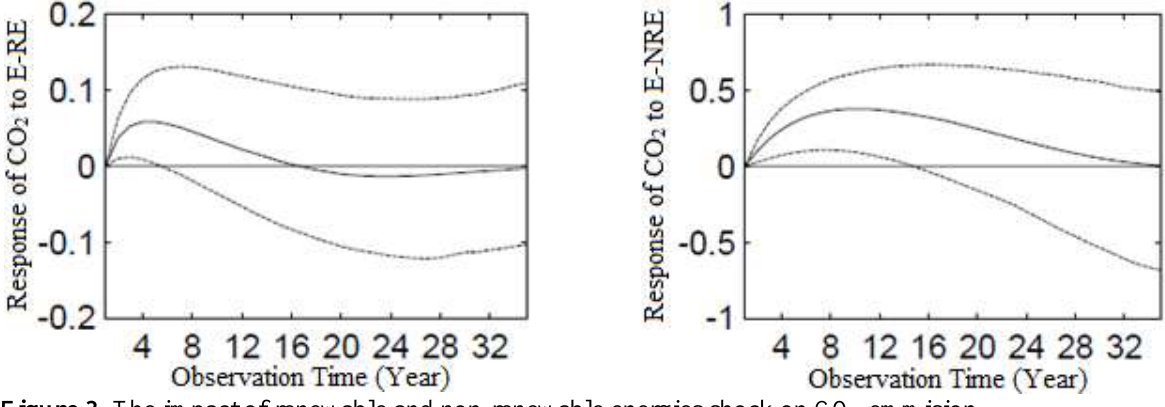
Figure 3. The impact of renewable and non-renewable energies shock on CO Source: Research